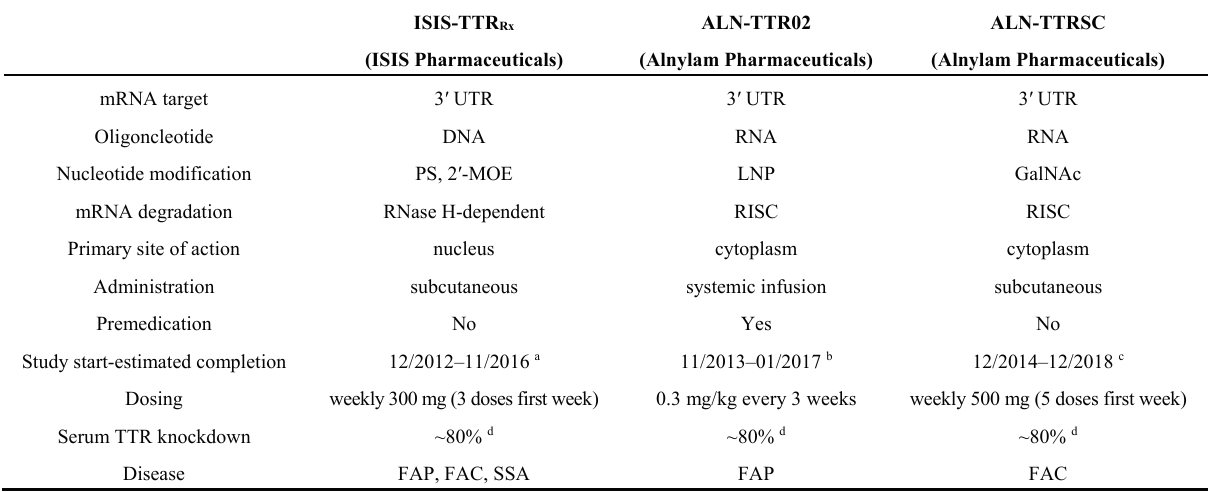
Table 1. Therapeutic oligonucleotides currently used in clinical trials of TTR